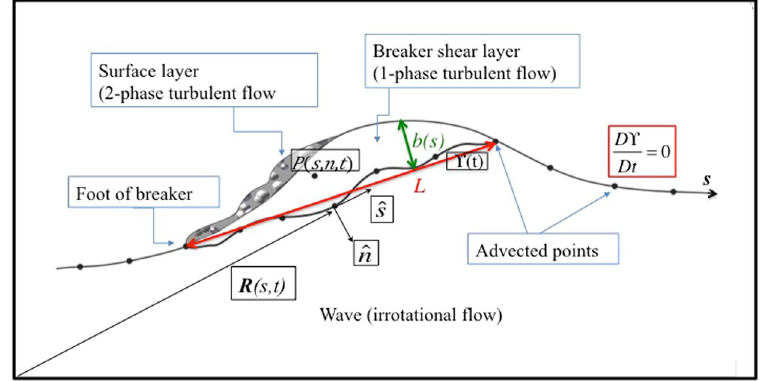
Figure 1. Schematic view of the theoretical model of Brocchini 9 (taken from Lucarelli et al . 11 ).